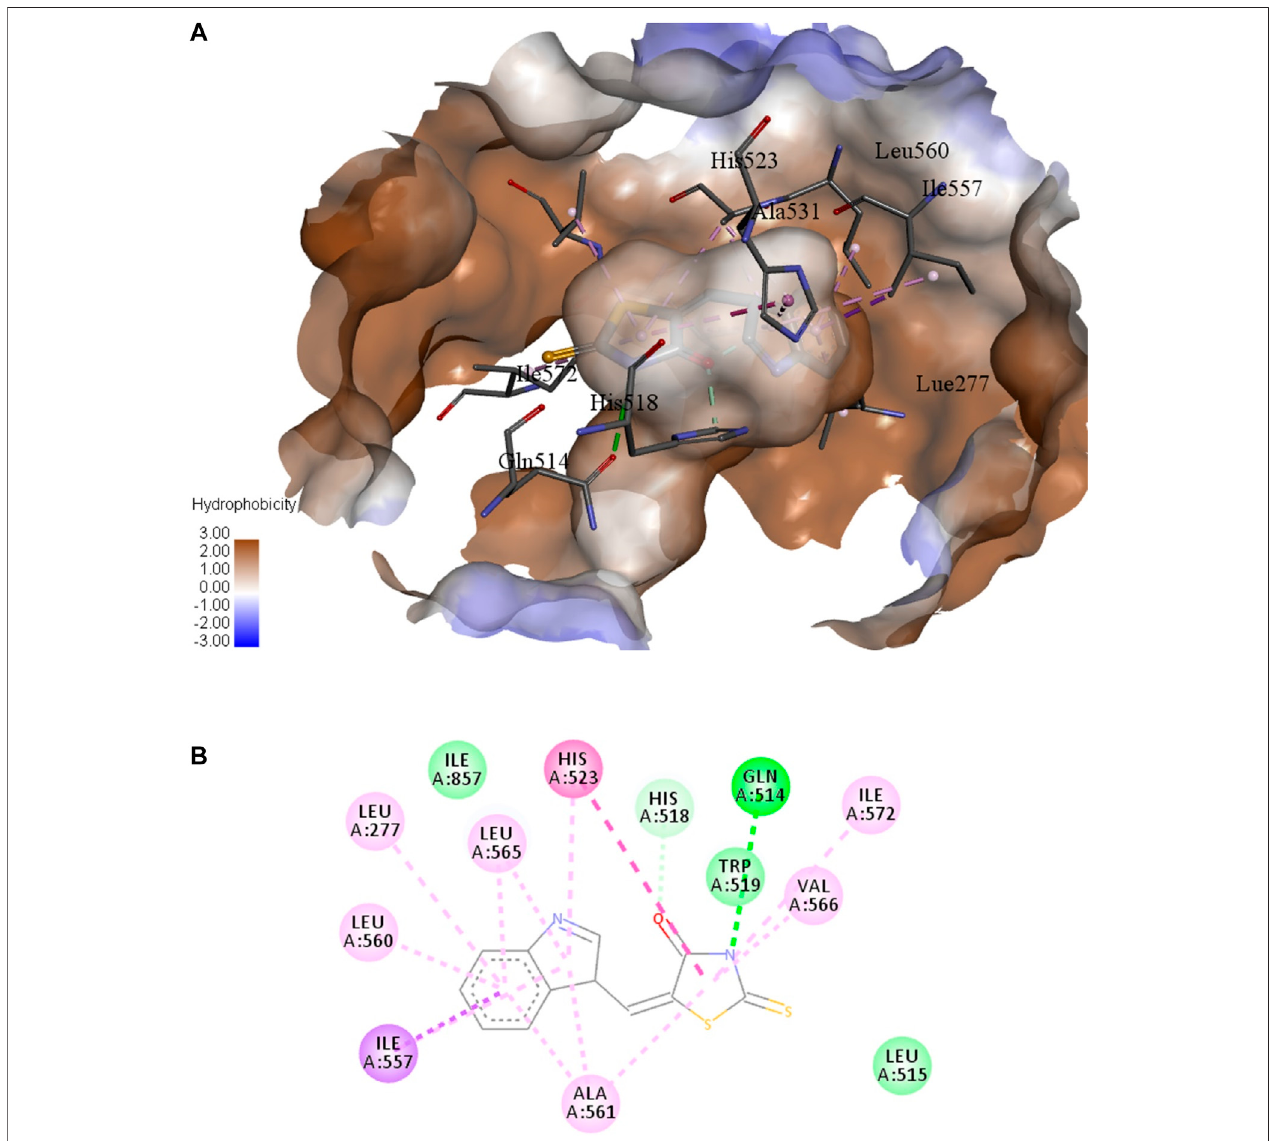
FIGURE 6 | (A) Hydrophobic surface representation of soybean LOX-3 binding site with docked compound 1s . (B) 2D representation of the main interactions of compound 1s with residues in binding site of LOX-3: green = conventional hydrogen bond; light green = van der Waals; very light green = carbon-hydrogen bond; dark purple = π -sigma; purple = π - π T-shaped; light purple = alkyl and π -alkyl.